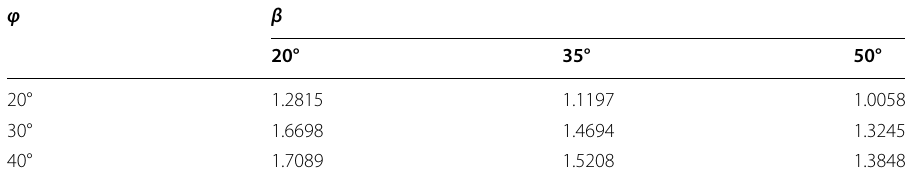
0.05 and q/γH 0 = =